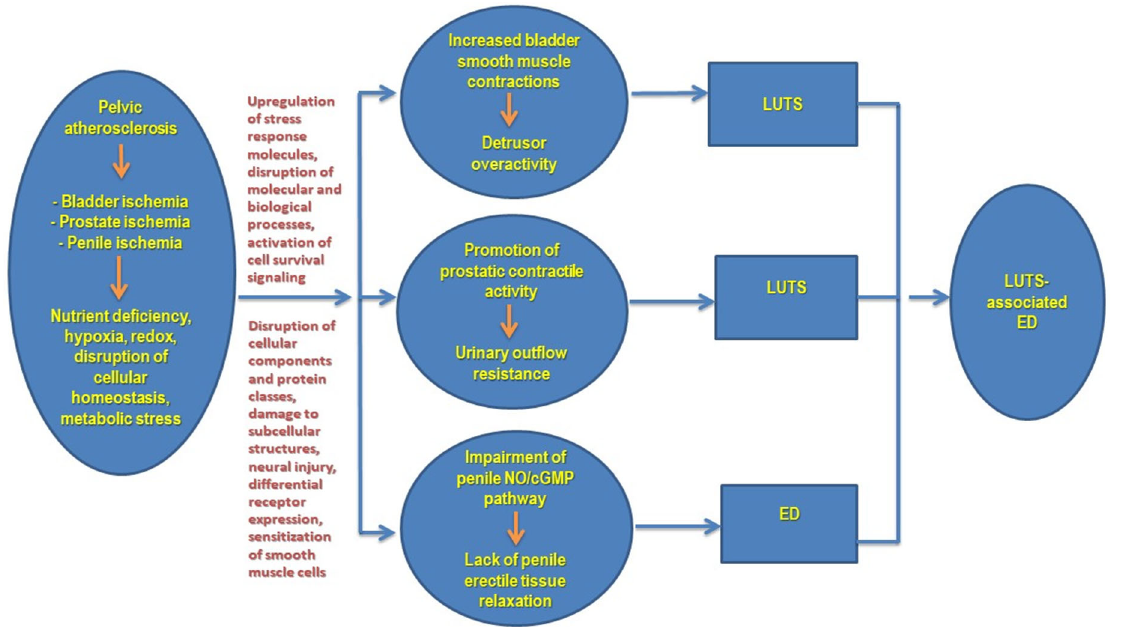
Figure 4. Conceptual presentation of pelvic ischemia as a unifying mechanism of LUTS-associated ED. It is believed that bladder ischemia contributes to non-obstructive non-neurogenic detrusor overactivity. Prostate ischemia promotes prostatic smooth muscle contractions and leads to urinary outflow resistance independent of prostate size. Penile ischemia disrupts the underlying mechanism of erectile tissue relaxation and impairs erectile activity. These changes, cumulatively, lead to the development of LUTS-associated ED. NO = nitric oxide, cGMP = cyclic guanosine monophosphate, LUTS = lower urinary tract symptoms, ED = erectile dysfunction.